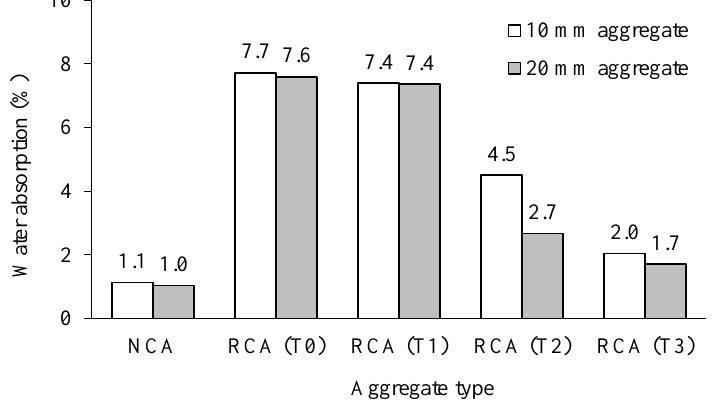
Figure 14. Water absorption results of NCA and RCA for two aggregate sizes of 10 and 20 mm.